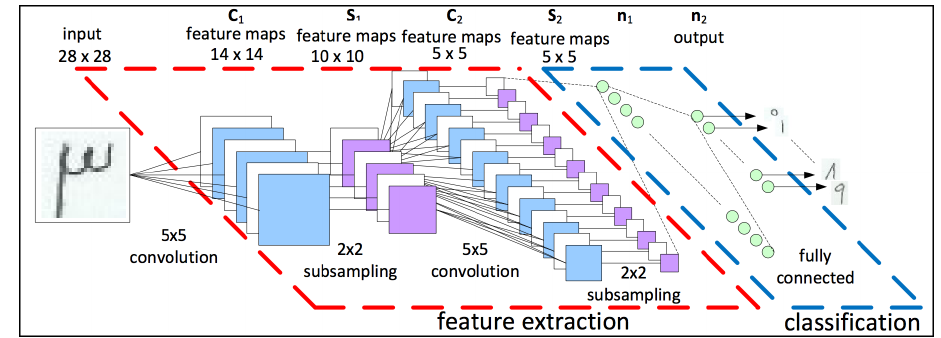
Figure 13. Inside architecture of our proposed CNN for Urdu handwritten character recognition